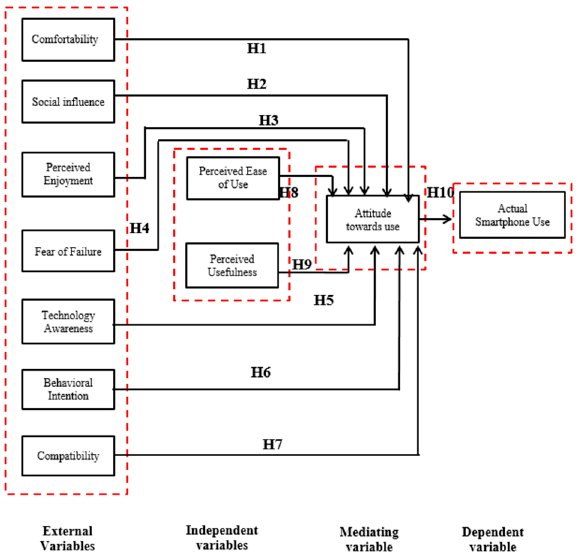
Figure 1. Conceptual framework—Smartphone Acceptance Model for Older People (SAMOP).